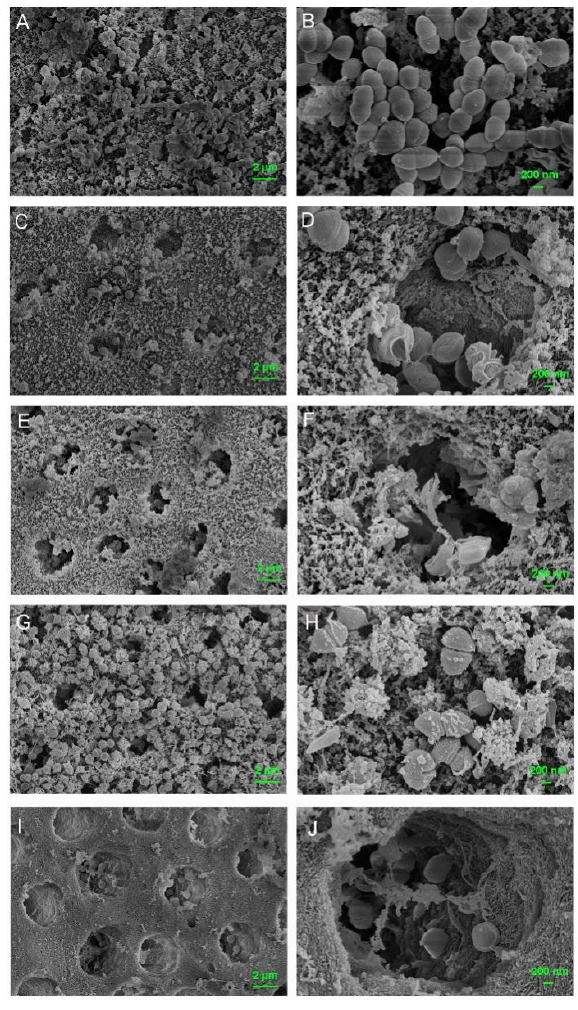
Figure 10. FE-SEM images of 4-week E. faecalis biofilm on dentin slices after 7-day medication. ( A , B